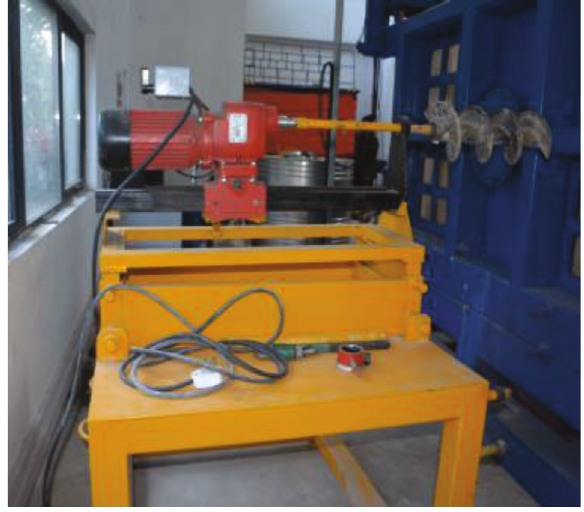
Figure 5: The tunnel excavation simulation system [42].